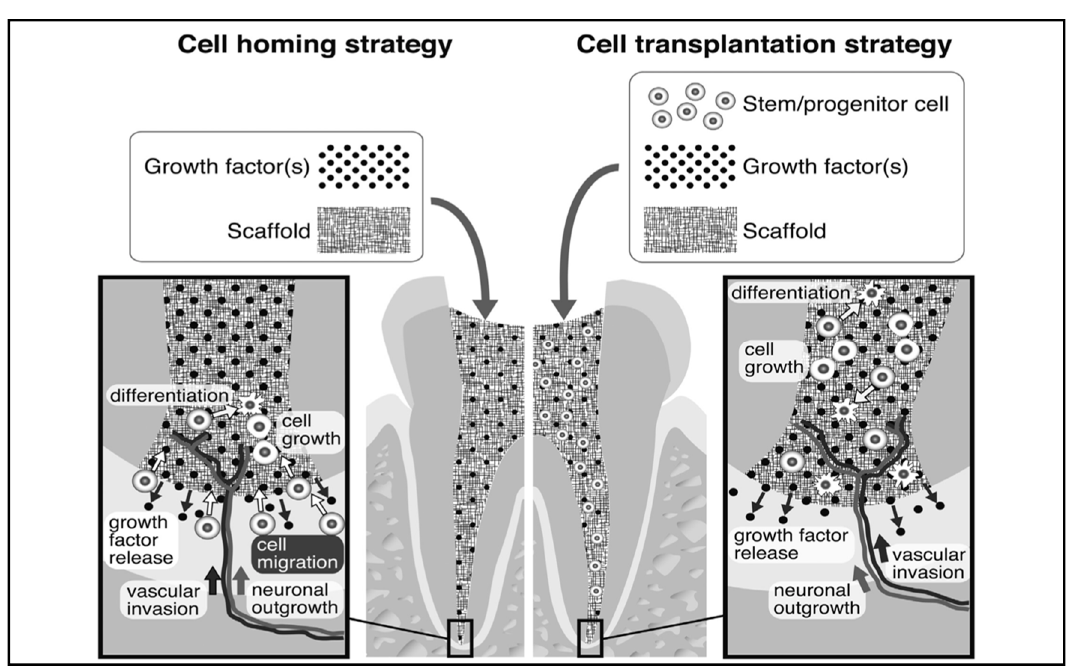
Figure 2. Strategies for dentin pulp complex regeneration: the cell homing strategy involves injection of growth factors and scaffolds into the pulp tissue, which leads to proliferation and migration of progenitor cells from the apical pulp tissue. In cell transplantation, the stem cells are injected to the pulp space along with growth factors and scaffolds to induce pulp regeneration. In both scenarios, cell growth or proliferation due to growth factors or peripheral induction is followed by scaffold colonization, which in cases with resorbable scaffolds leads to formation of new tissue over time. Image reprinted with permission from Morotomi et al. [64]. Table 4. Cell-based therapies for dentin pulp complex regeneration (cell transplantation strategies).